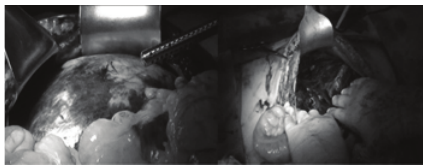
Figure 3: Intraoperative findings of a retroperitoneal hematoma causing increased intra-abdominal pressures.